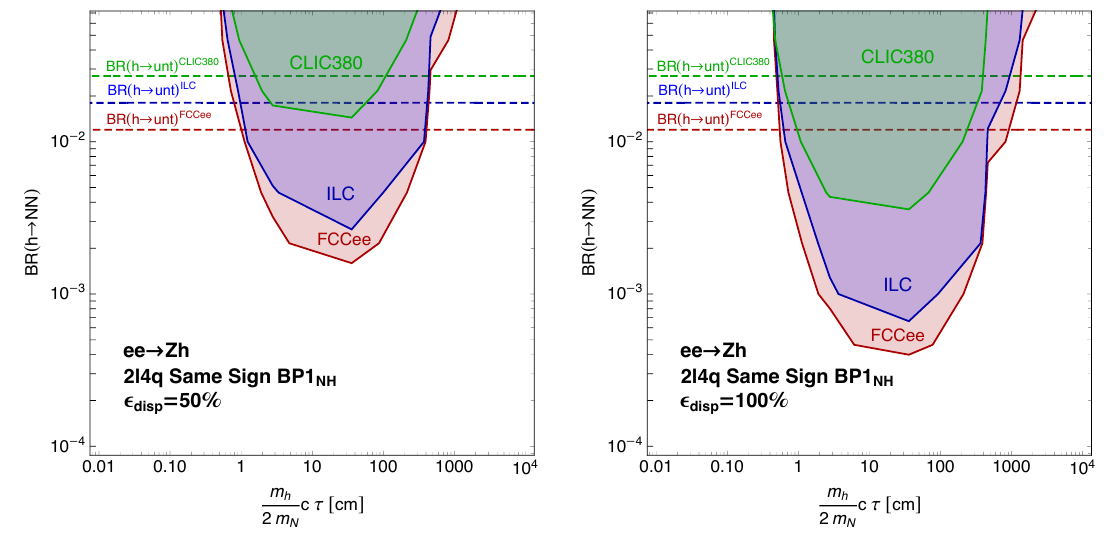
Figure 8 . 95% CL exclusion for BP1 NH in the m h cτ − BR( h → NN ) plane from displaced decay 2 m N searches in the Higgs-strahlung channel assuming (cid:15) disp . = 50% (left) and 100% (right). The shaded red areas represent the sensitivities for the different collider options while the colored dashed lines the limits arising from untagged Higgs decay